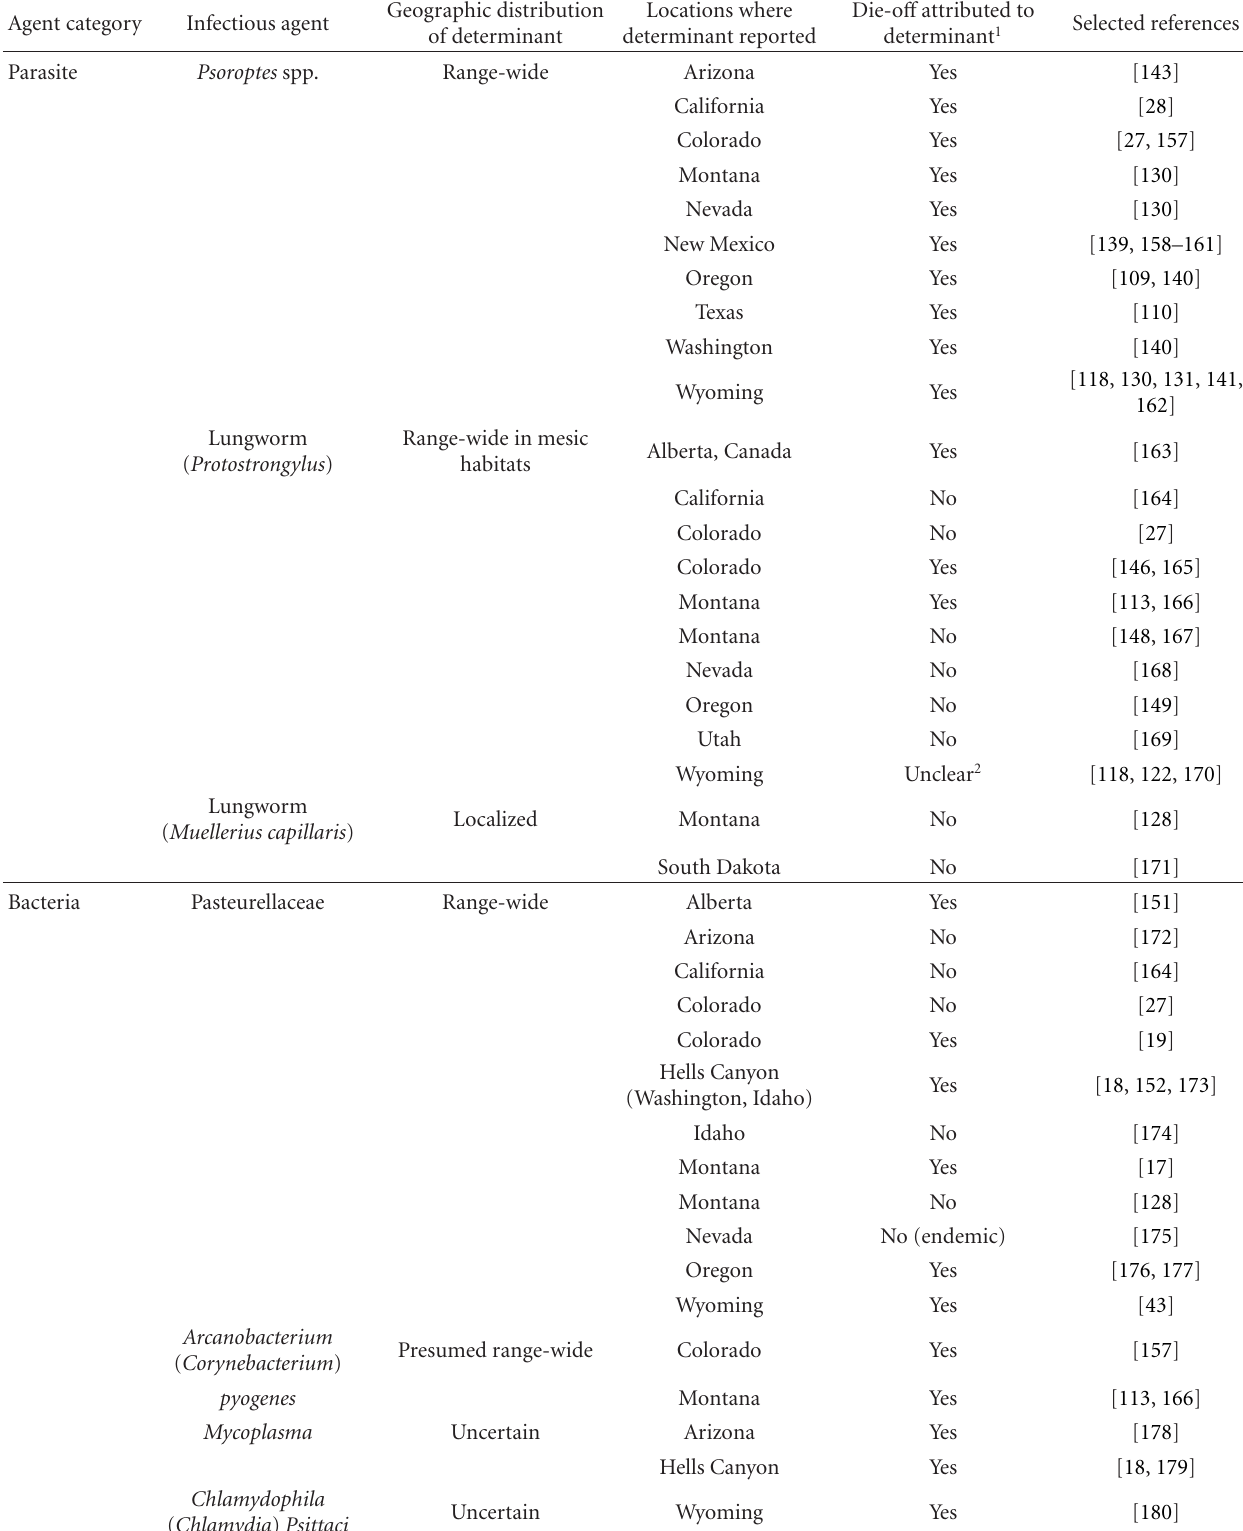
Table 3: Infectious agent determinants proposed to limit free-ranging bighorn sheep